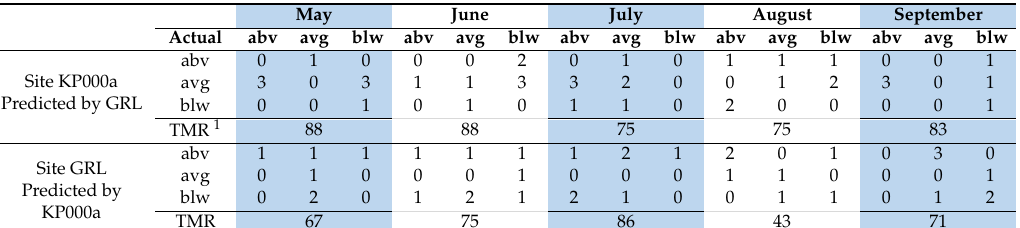
Table 3. Discriminant analysis confusion matrices from cross-site prediction showing actual and predicted class membership for the months May through September for both sites. AGFM classes are above average (abv), average (avg), and below average (blw) above-ground forage biomass. The total misclassification rate (TMR) for each month is also shown, and is calculated as the number of misclassifications divided by the total number of observations. Site KP000a class membership predicted from GRL discriminant analysis algorithm, GRL class membership predicted from site KP000a discriminant analysis algorithm.